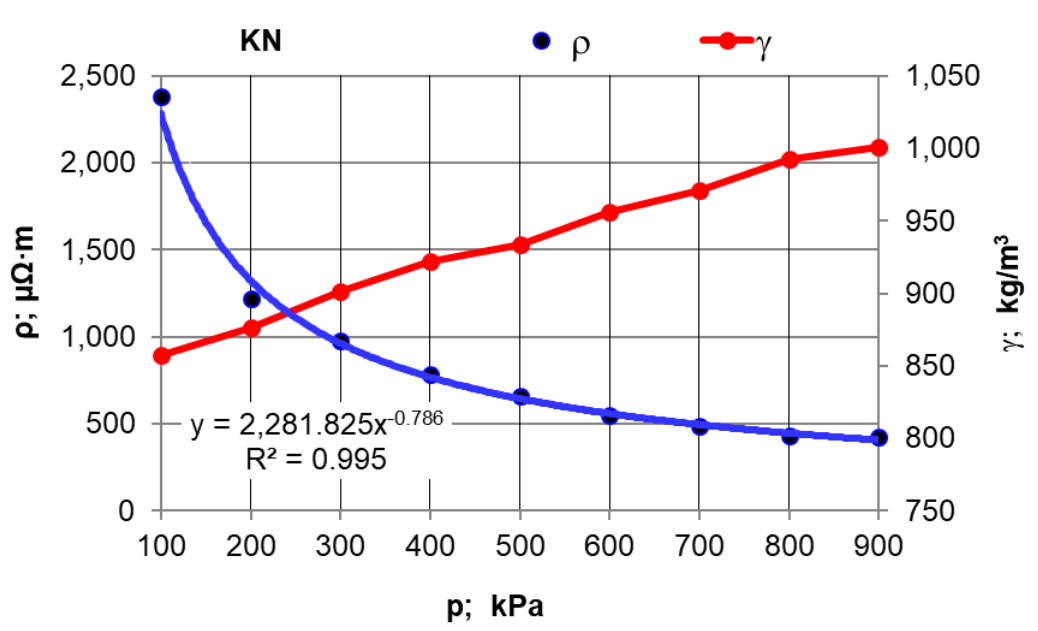
Figure 4. Resistivity and density versus the pressure value for the KN carburiser.